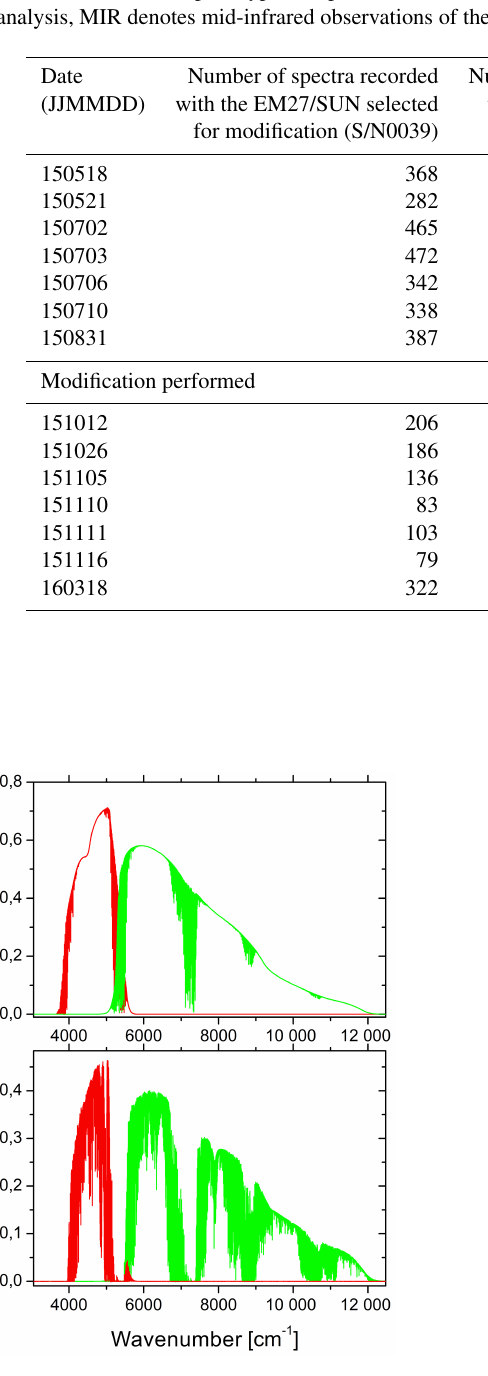
Figure 5. Lamp spectrum (top) and solar spectrum (bottom) recorded with the dual-channel prototype. The primary detector covers the spectral section observed with the standard EM27/SUN; the secondary detector covers the 4000–5500cm − 1